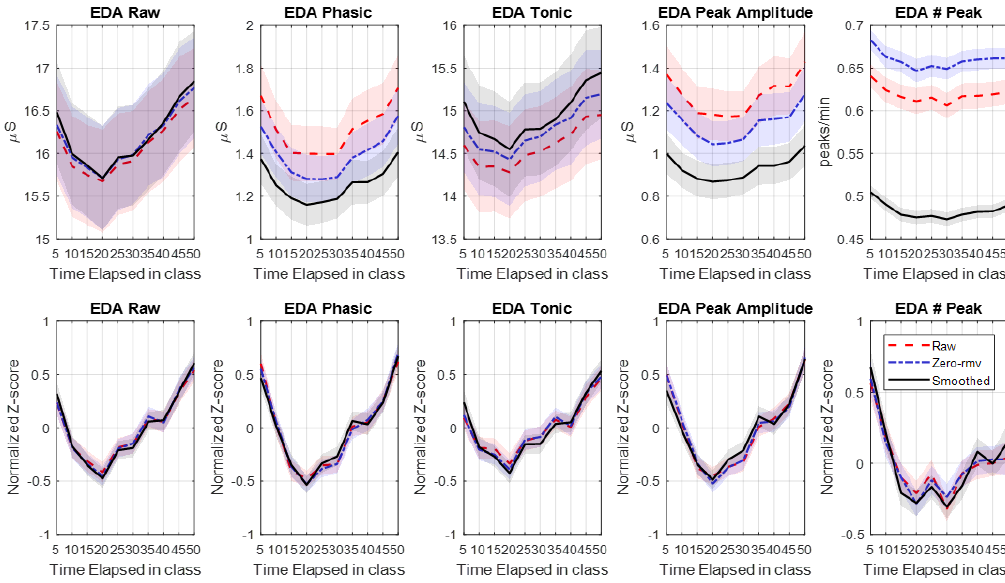
Figure 11. Comparison of (absolute and normalized) features calculated from raw EDA signals (Raw), signals after removing invalid portions (zero-rmv), and signals after applying the Savitzky–Golay (S-G) filter (smoothed) for all participants. A shade area represents SD/